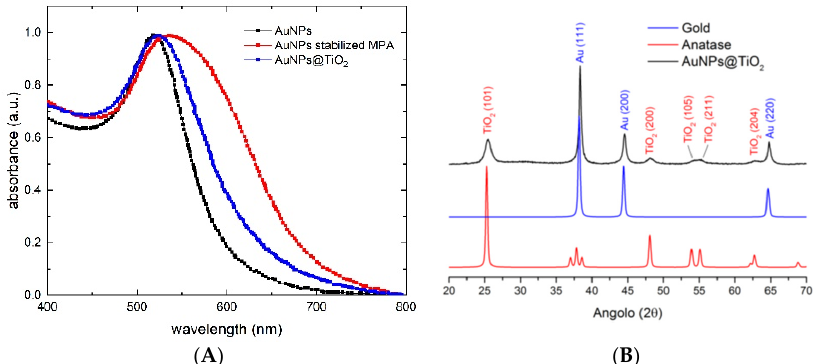
Figure 3. ( A ) Comparison of absorption spectra of bare and capped gold nanoparticles with embedded Au@TiO 2 . ( B ) Comparison of XRD patterns of gold, anatase and Au@TiO 2 .